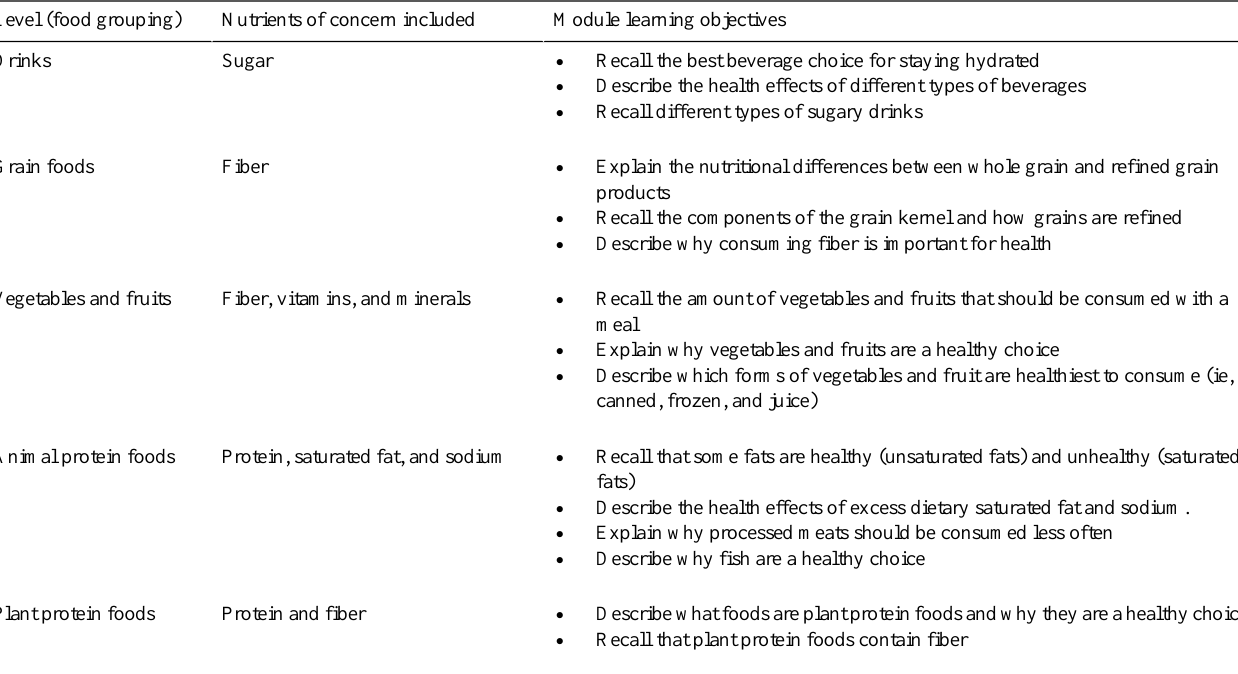
Table 1. Foodbot Factory modules, nutrients of concern, and learning objectives.